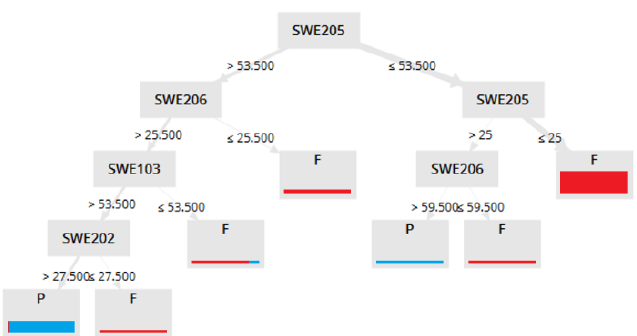
Fig. 12. Decision tree with Gini index for dataset 2